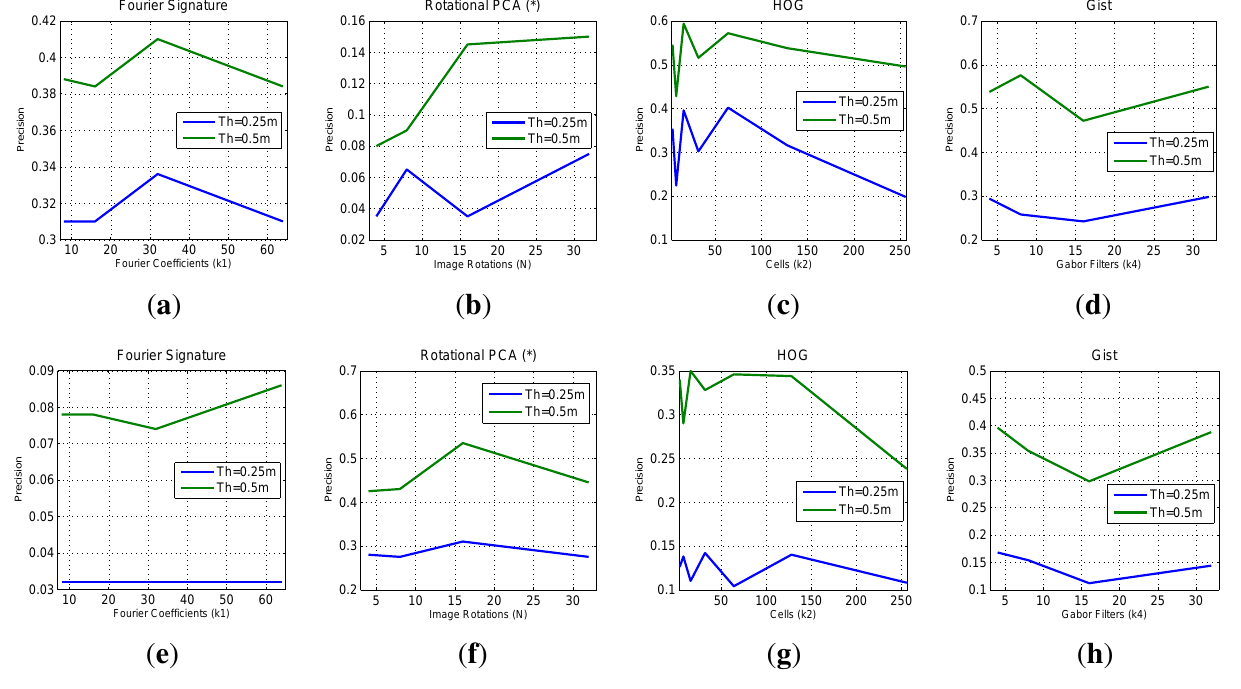
Figure 13. COLD database. Precision in localization using the sunny images as map database and ( a ), ( b ),( c ), ( d ) cloudy images and ( e ), ( f ), ( g ), ( h ) night images as test.